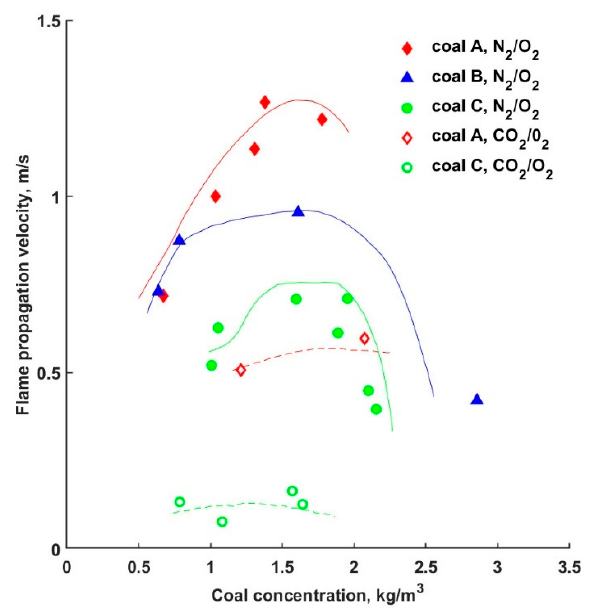
Figure 3. Flame propagation velocity in air and the simulated oxyfuel atmosphere for three different types of coal (A, B, C). Adapted with permission from Ref. [57] Copyright © 2006 Elsevier Ltd.